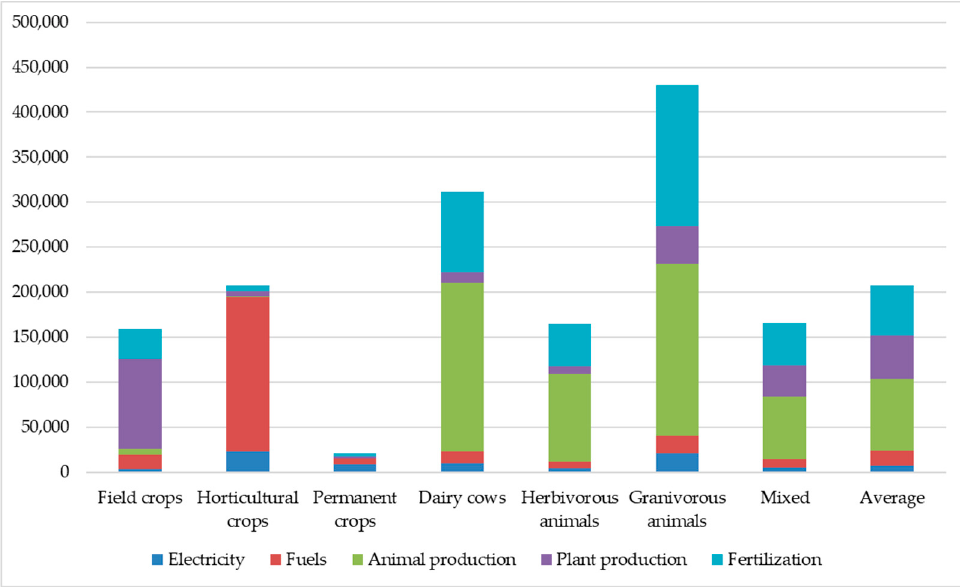
Figure 6. GHG emission in particular types of farms in kg. Source: own study.